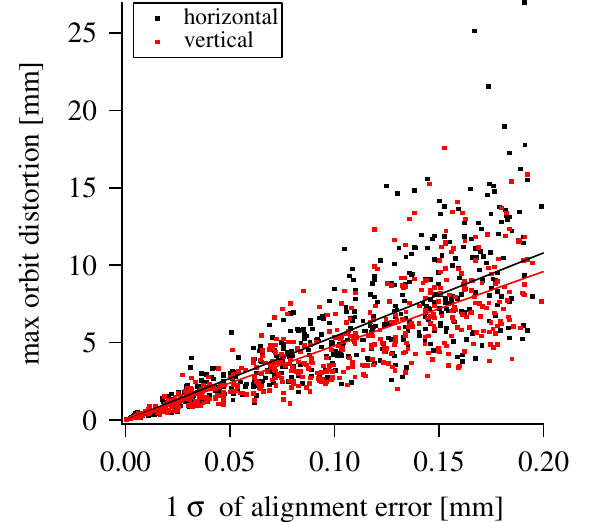
FIG. 7. (Color) Maximum orbit distortion against alignment errors. Straight lines indicate linear